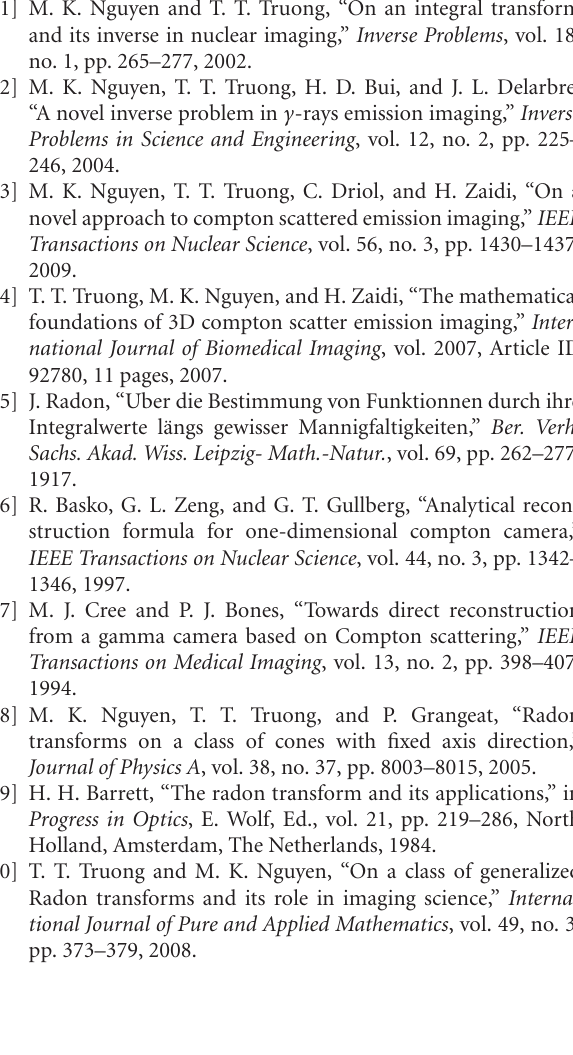
Figure 7: FBP-IM reconstruction of the defect with dω = 0 . 005